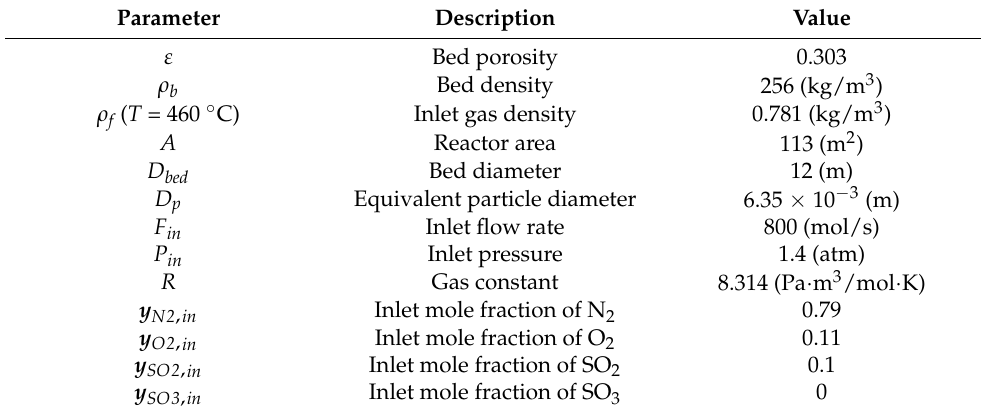
Table 3. Reactor system simulation